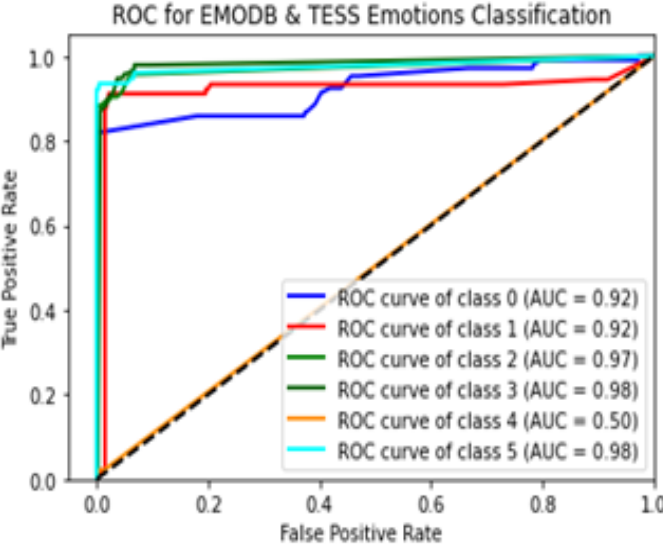
Figure 7. ROC curve of classification.